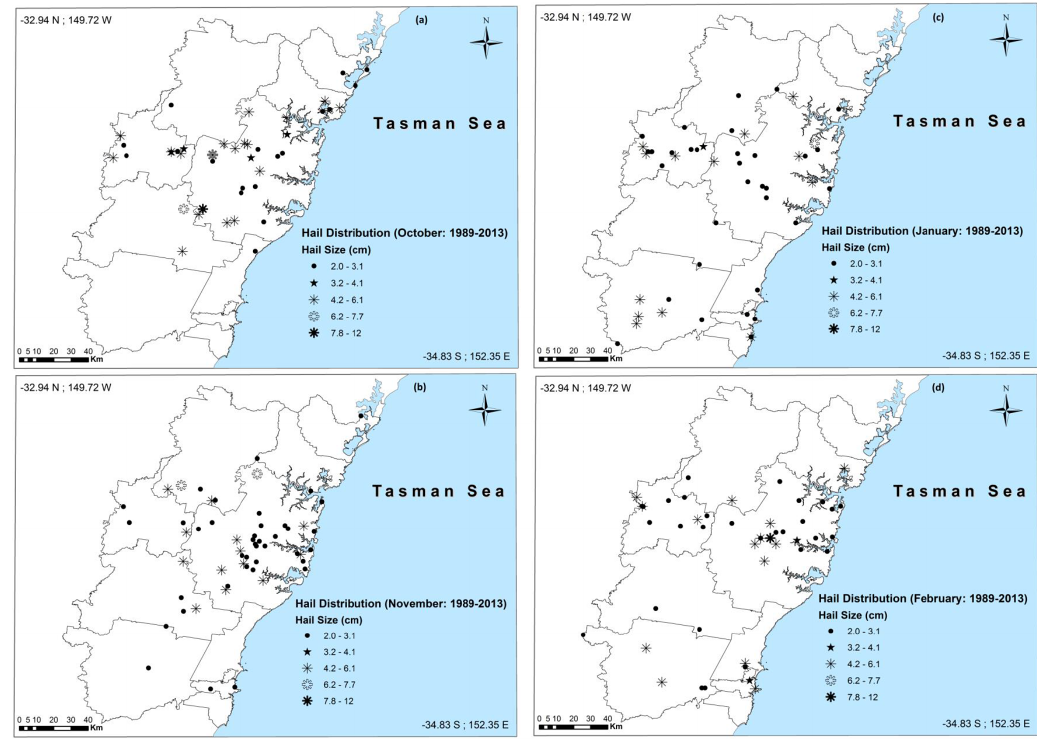
Figure 6. Spatial distribution of hail events during the warm months of (a) October, (b) November, (c) January and (d) February.